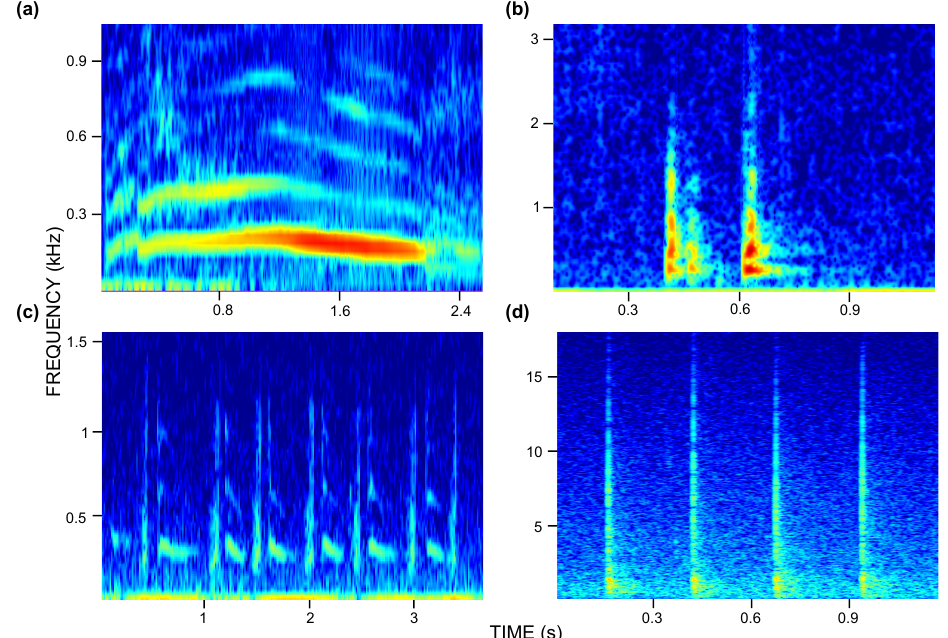
Figure 4. Underwater sounds produced by grey seals: ( a ) moan, ( b ) rups, ( c ) series of rupes, and ( d ) forelimb